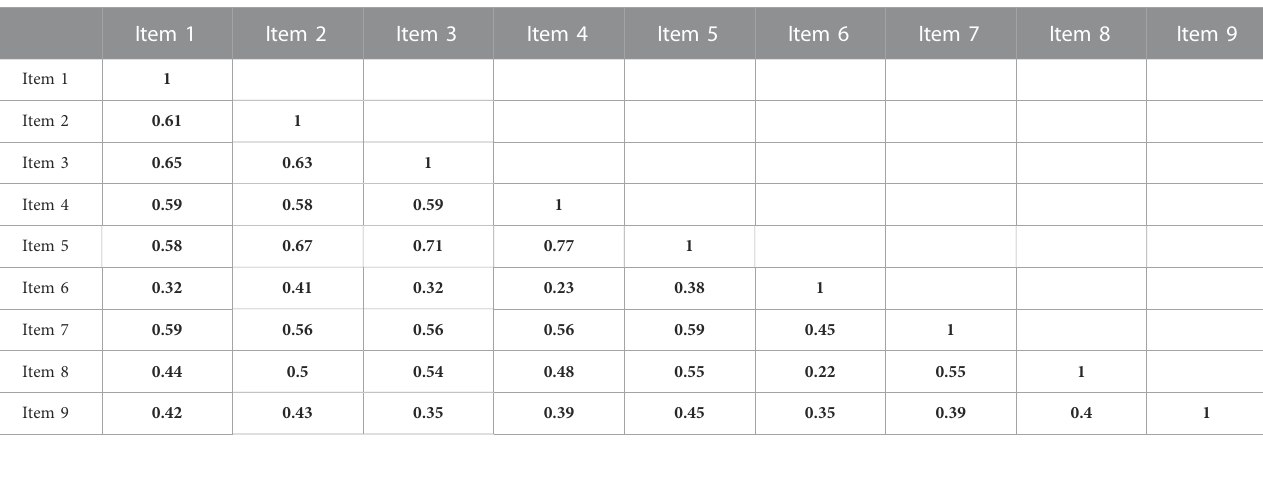
TABLE 3 Correlation matrix for items 1 – 9 (N = 143).